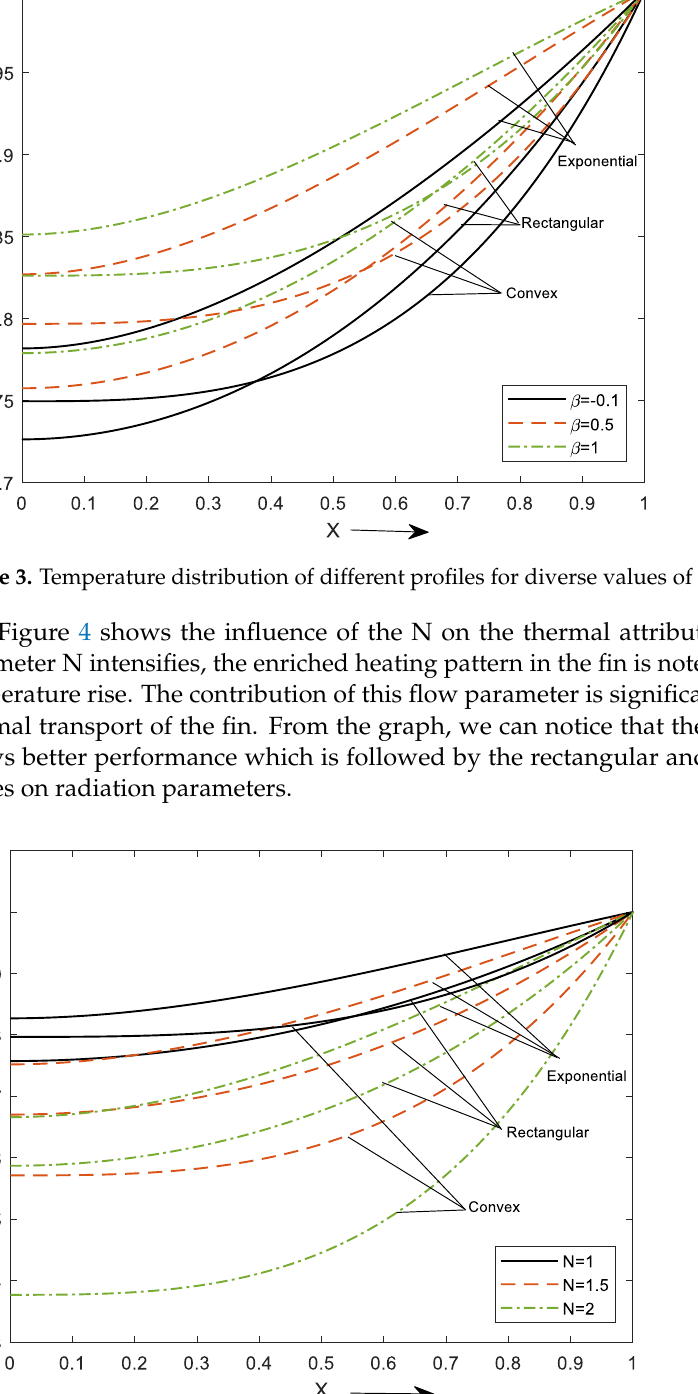
( ) G is depicted in Figure 5. is depicted in Figure 5.